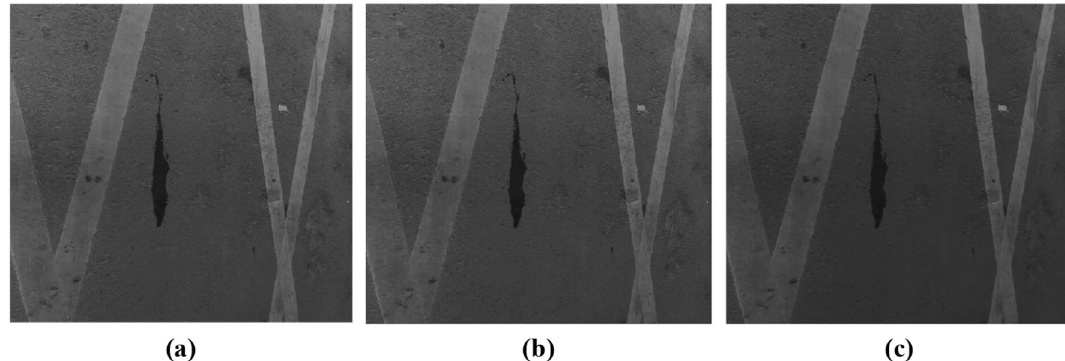
Figure 6. Image gray processing ( a ) cvtColor; ( b ) meanGray; ( c )